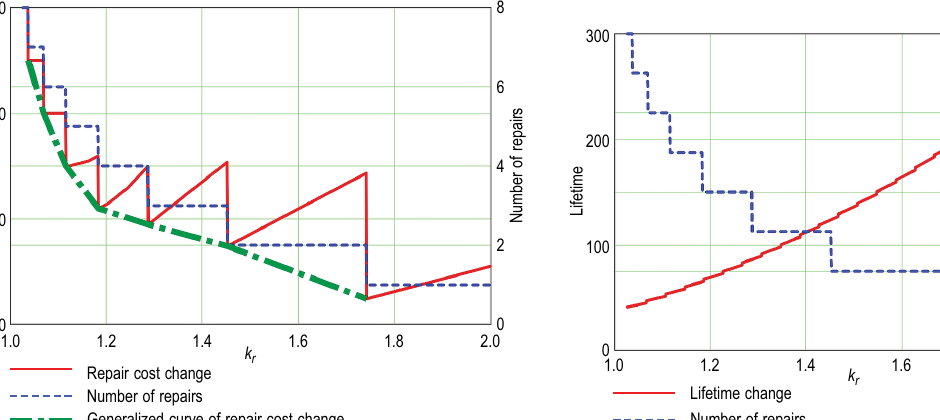
Fig. 6. Dependence of service life and repairs amount from r